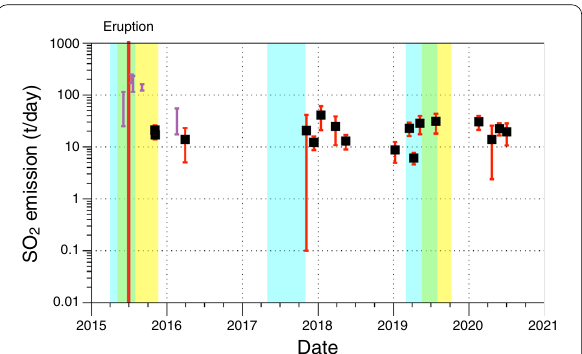
Fig. 7 Sequential change of SO 2 emission from Owakudani steaming area (after Abe et al, 2018). Black squares with error bars indicate measurements by Meteorological Research Institute (2015, 2016) and Hot Springs Research Institute of Kanagawa Prefecture (after 2017), while others (error bars only) are measurements by